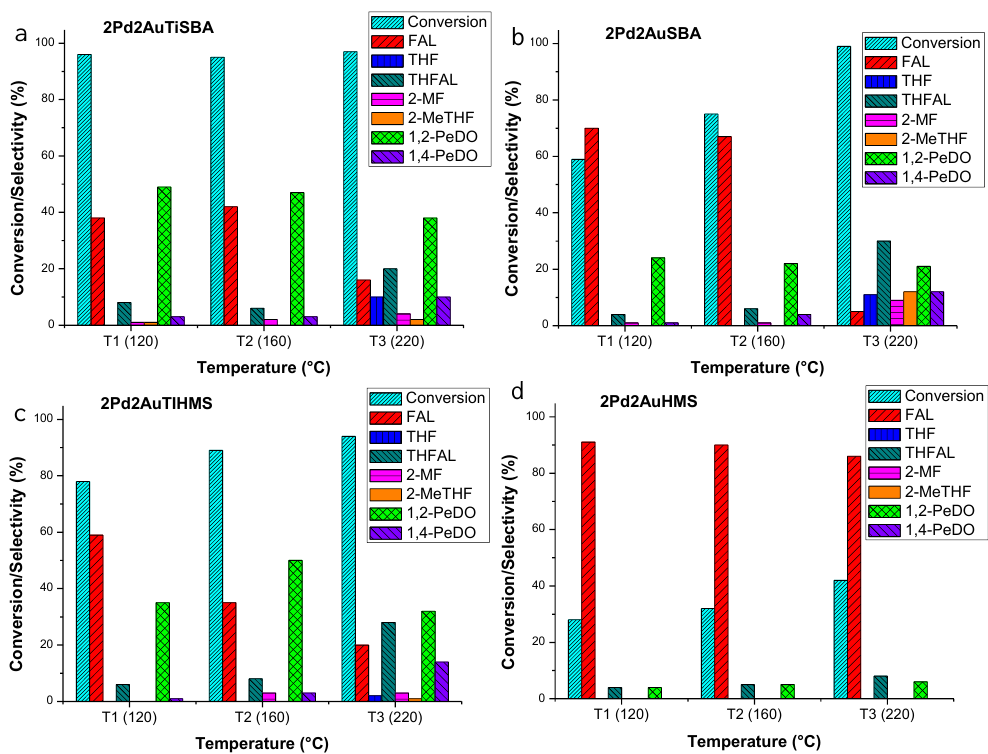
Figure 1. Effect of temperature in FFR hydrogenation over 2Pd2Au Ti-doped SBA and HMS ( a , c ) and un-doped ( b , d ) catalysts. Reaction conditions: furfural 2.5 g; catalyst 0.25 g; H 2 500 psi; 1000 rpm; reaction time 5 h.